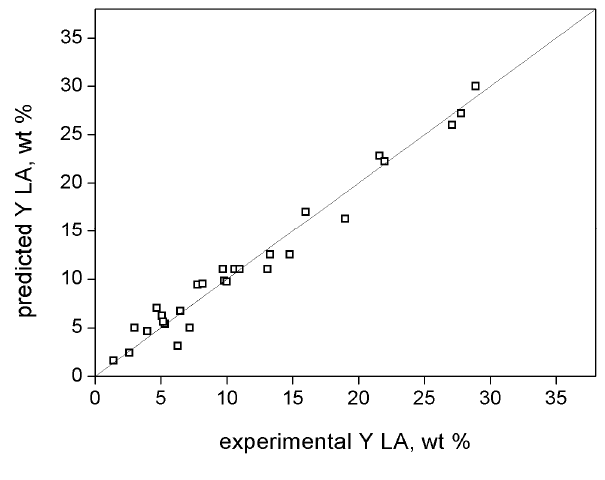
Figure 12. Parity plot for LA yield. Table 5. Analysis of variance of the preferred model of LA.